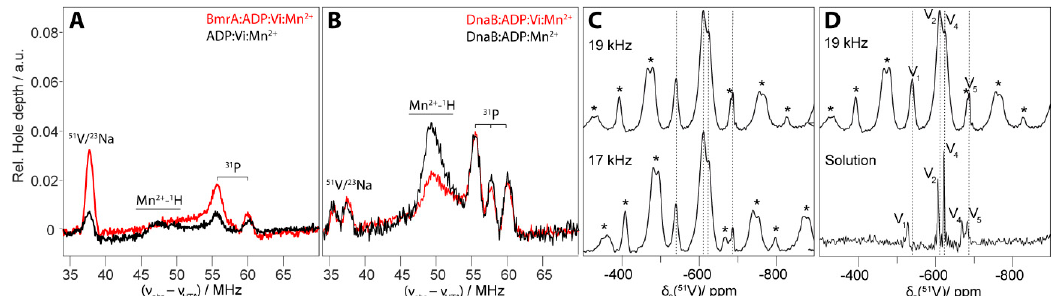
Figure 7. Localisation of the vanadate ion using NMR and EPR experiments. Background corrected 94 GHz EDNMR spectra of BmrA ( A ) and DnaB ( B ) incubated with Mn 2+ and ADP, with and without vanadate. For 31 P, a doublet due to the hyperfine coupling to 31 P is observed (~4 MHz), as well as a singlet not assigned so far [122]. 51 V spectra of DnaB:ADPMg:DNA:Vi recorded at a MAS frequency of 17 and 19 kHz ( C ). 51 V spectra of DnaB:ADPMg:DNA:Vi overlaid with the solution-state spectrum of ADPMg:Vi ( D ). Central transitions are indicated with dashed lines whereas spinning sidebands are indicated with a black star. All panels represent original